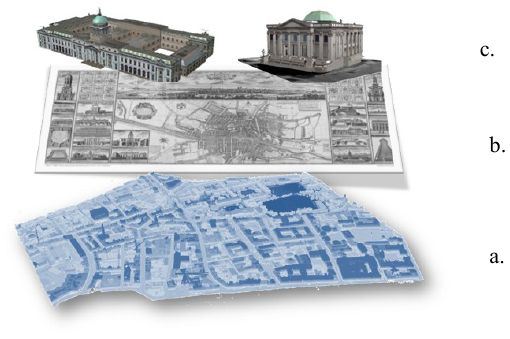
Figure 1: Dublin City Aerial Scan, Historic Maps and 3D